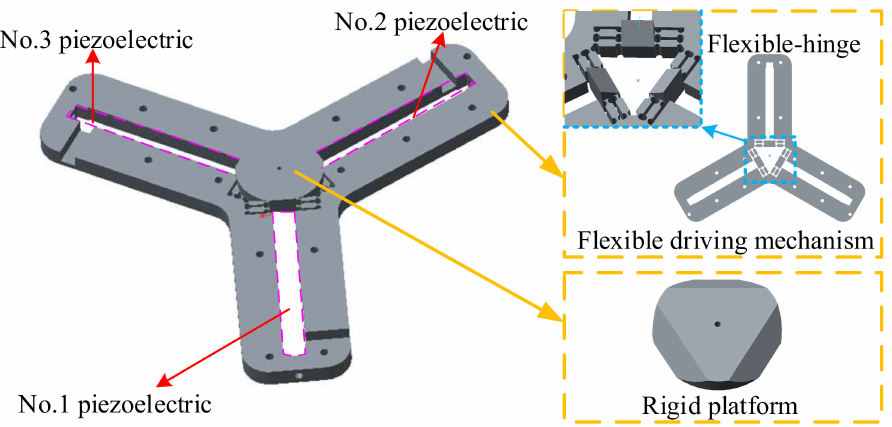
Figure 1. Symmetrical rigid-flexible coupling micro-positioning